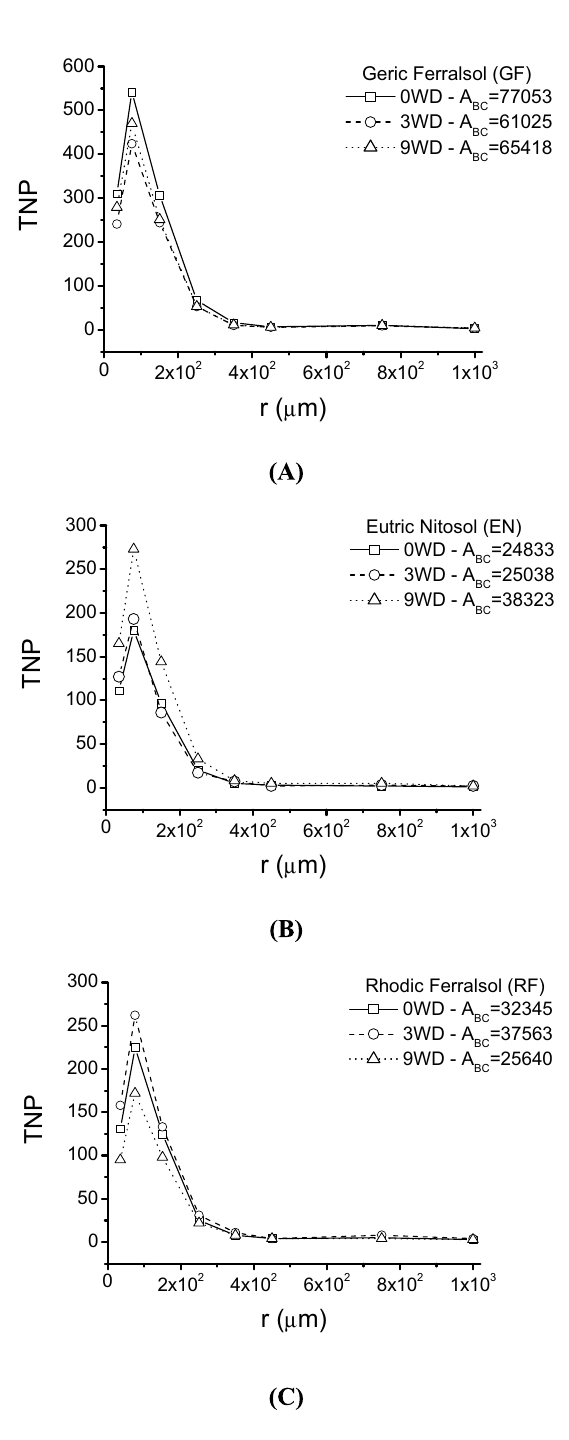
Fig. 3–Changesintotalnumberofpores(TNP)fordifferentporeradii with repetitions of wetting and drying (W-D) cycles. A BC represents the calculated area below the